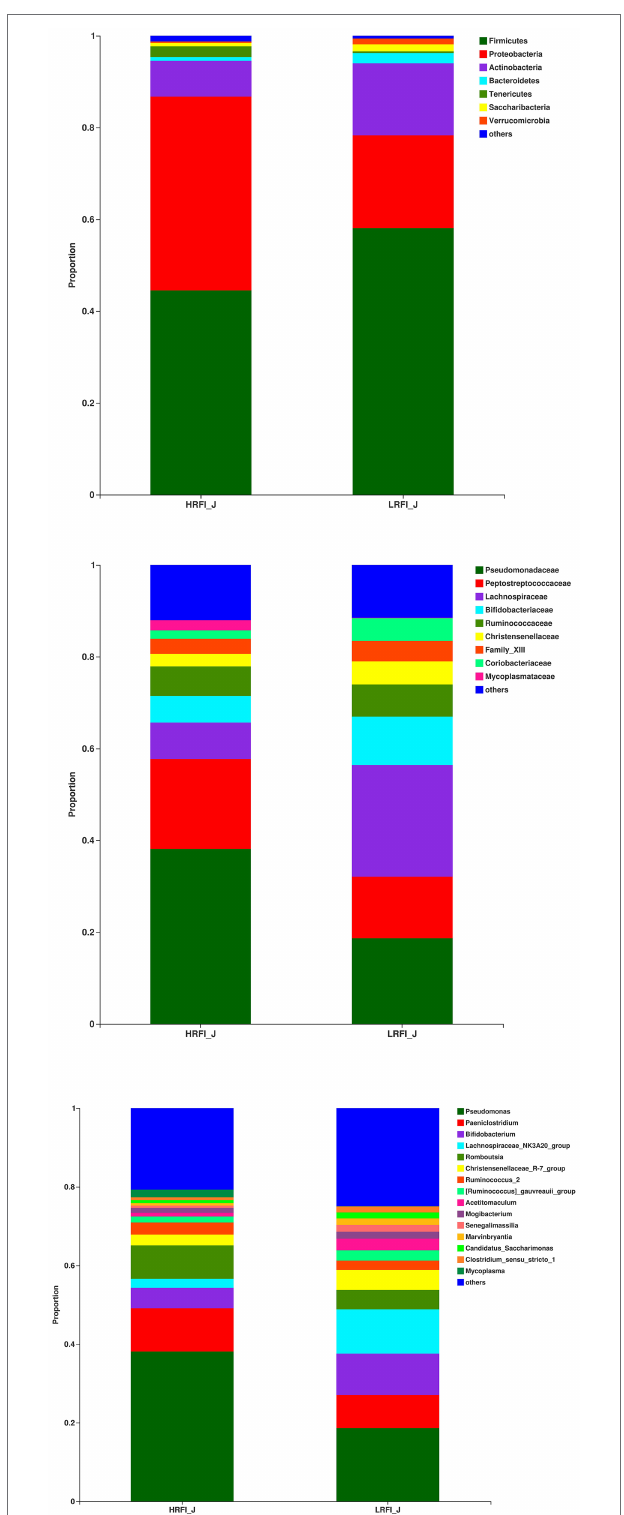
FIGURE 4 | The average proportion of the most dominant ileum bacteria phyla, families, and genera (relative abundance >1% for all